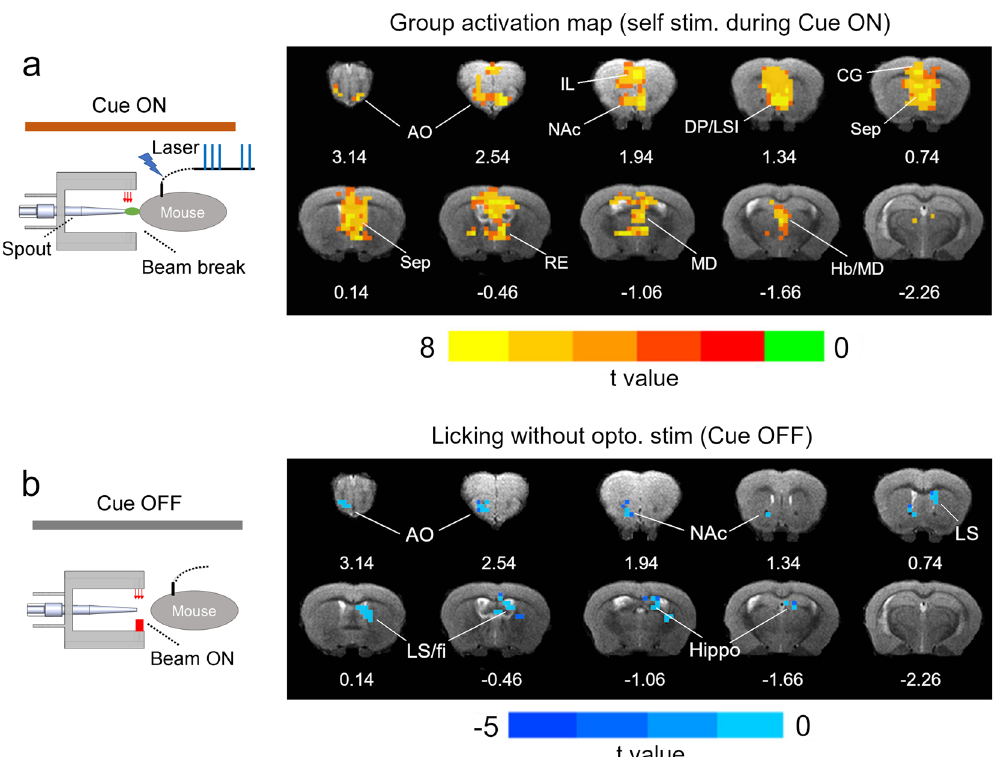
Fig. 3 BOLD activation during Cue ON and Cue OFF. a Group activation maps following optogenetic self-stimulation during the Cue ON period ( N = 10, corrected p < 0.01). Activated areas include: anterior olfactory nucleus, cingulate cortex (CG1/CG2), prelimbic and infralimbic cortex (IL), nucleus accumbens core (NAc), septum, reuniens thalamic nucleus (RE), medial dorsal (MD) thalamic nucleus and habenula. b Group activation maps during Cue OFF period when mice licked the spout in the absence of Opto-ICSS ( N = 10, corrected p < 0.01). Negative BOLD responses were detected in anterior olfactory nucleus (AO), anterior nucleus accumbens (NAc), dorsal and fi mbria ( fi ) hippocampus and lateral septum (LS). Numbers below images are coordinates relative to